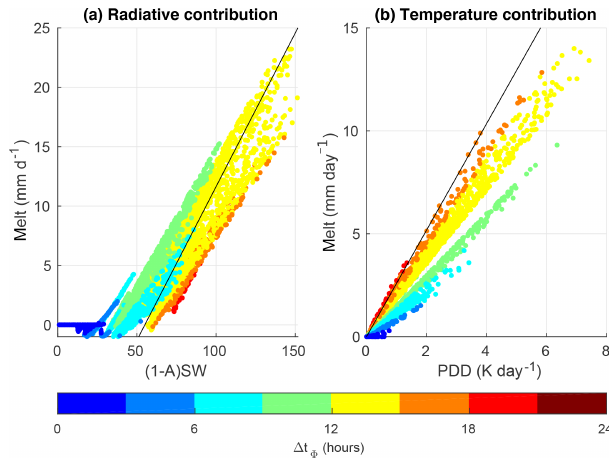
Figure 1. (a) Contribution of the first and third terms (radiative con- tribution) and (b) of the second term (temperature contribution) in Eq. (6) to monthly melt rates diagnosed with climatological tem- peratures and solar radiation from the MAR simulation. Colours indicate length of melt period (hours). The black lines represent the respective prediction of the dEBM const according to Eq.